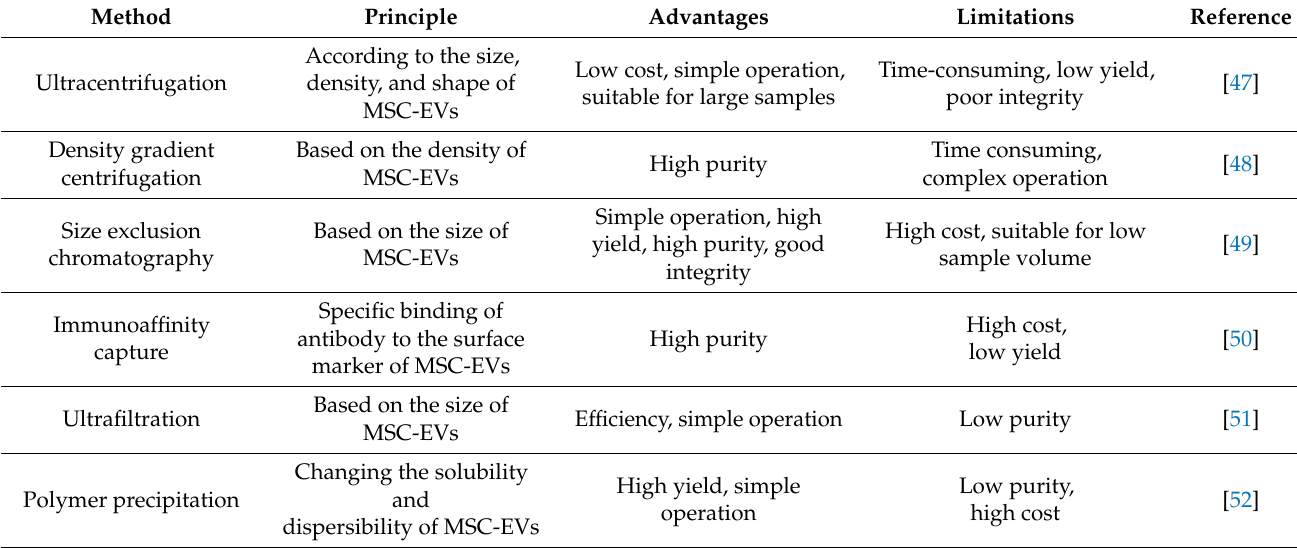
Table 1. Evaluation of isolation methods of MSC-EVs.